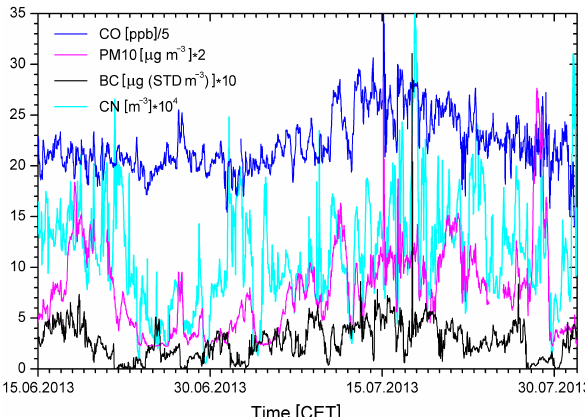
Figure 4. Overview of selected species measured at UFS between 15 June and 1 August 2013: during the fire period in July elevated CO was observed parallel to the increase in particles, which had not been the case in June. BC means black carbon, and CN condensa- tion